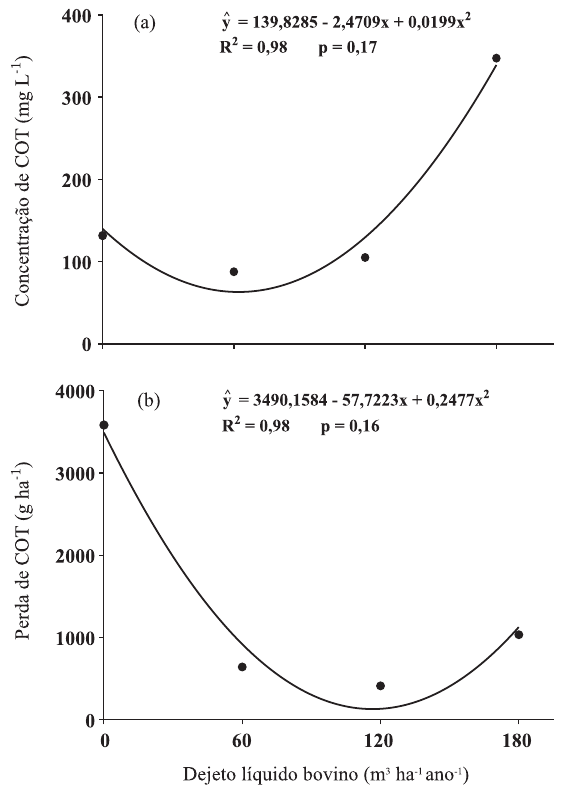
Figura 1. Concentração média ponderada de carbono orgânico total (COT) (a) e perda acumulada de COT (b) em escoamento superficial sob chuva natural após a aplicação de doses de dejeto líquido bovino em Latossolo franco-argiloarenoso manejado sob plantio direto. Ponta Grossa-PR. Avaliações